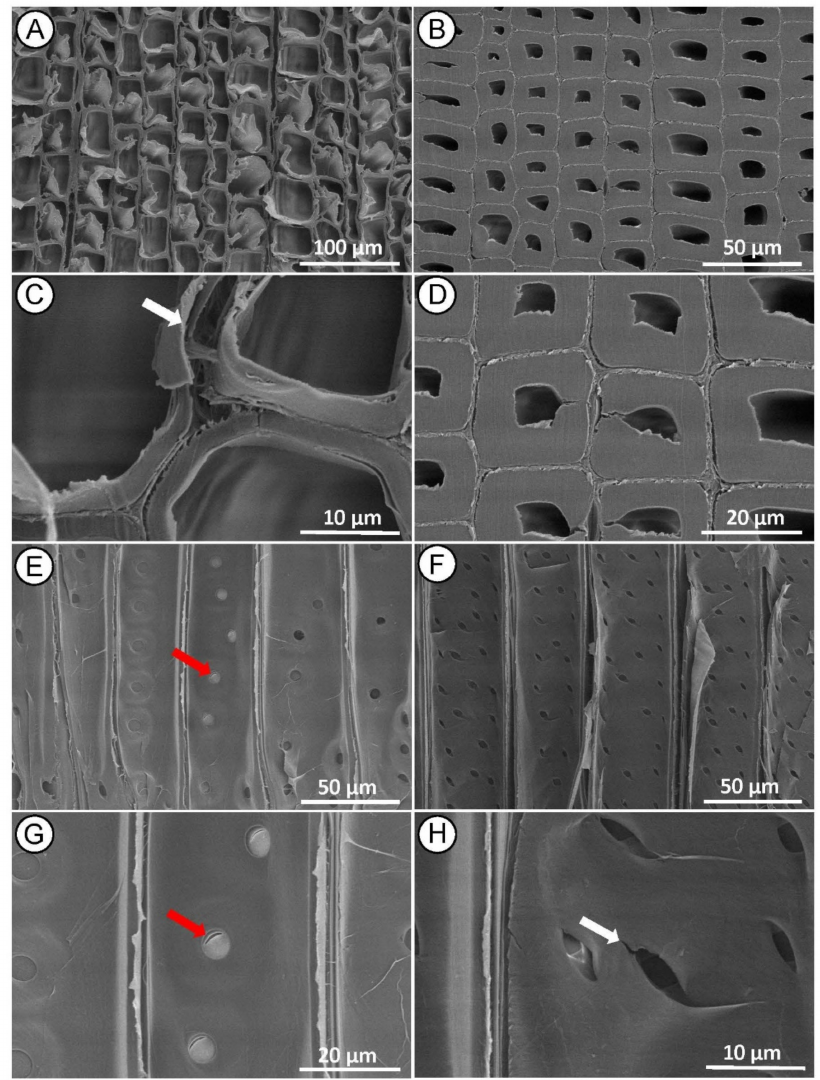
Figure 5. SEM micrographs of Norway spruce sapwood after MI MW treatment. Cross section showing collapsed tracheids in earlywood (( A , C )—white arrow) and mainly normal tracheids structure in latewood ( B , D ). Radial section showing bordered pits with damage to the pit membrane between the tracheid walls (( E , G )—red arrows) and evident cracks in piceoid cross-field pits poles (( F , H )—white